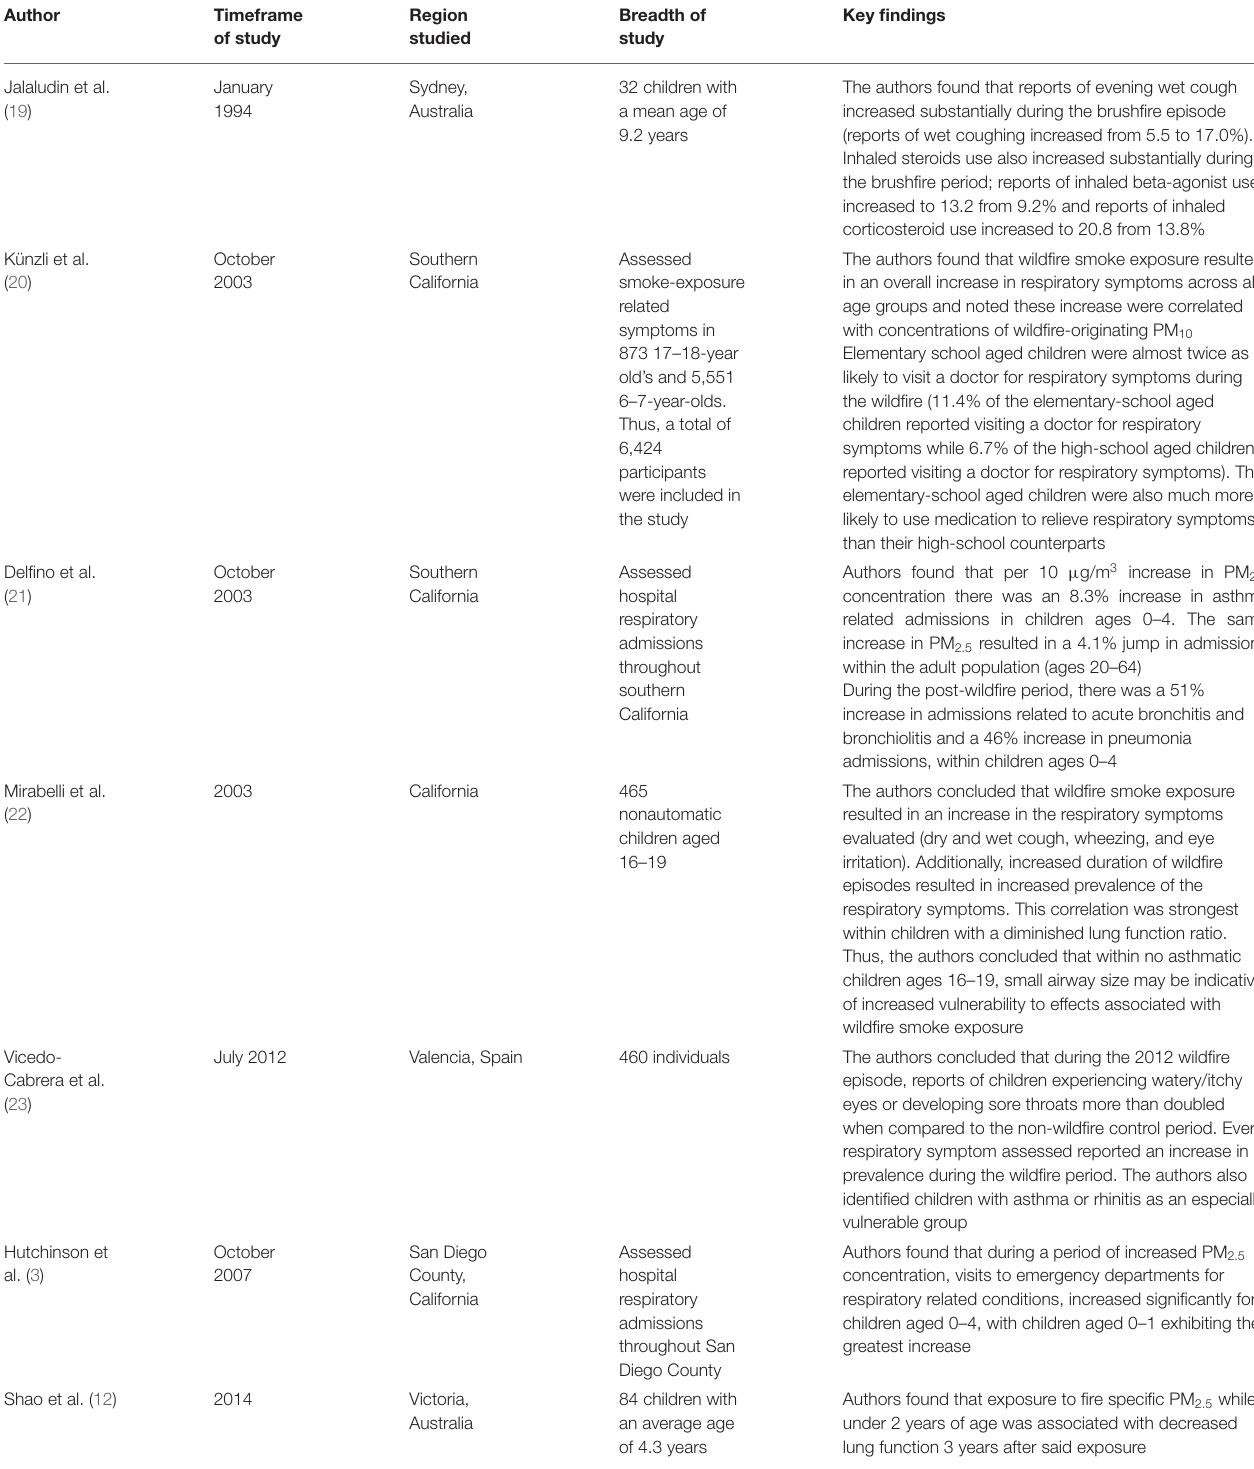
TABLE 1 | Summary of wildfire and PM 2.5 pediatric respiratory impact studies reviewed (organized chronologically by year